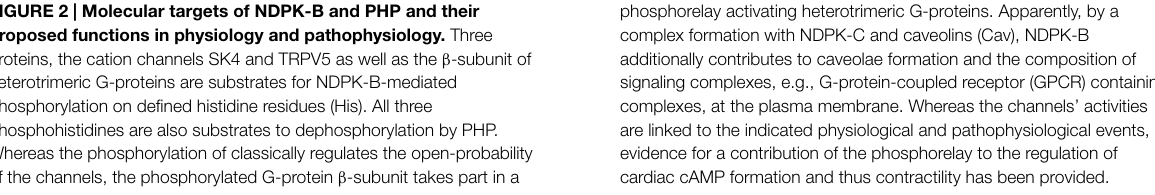
phosphorelay activating heterotrimeric G-proteins. Apparently, by a complex formation with NDPK-C and caveolins (Cav), NDPK-B additionally contributes to caveolae formation and the composition of signaling complexes, e.g., G-protein-coupled receptor (GPCR) containing complexes, at the plasma membrane. Whereas the channels’ activities are linked to the indicated physiological and pathophysiological events, evidence for a contribution of the phosphorelay to the regulation of cardiac cAMP formation and thus contractility has been